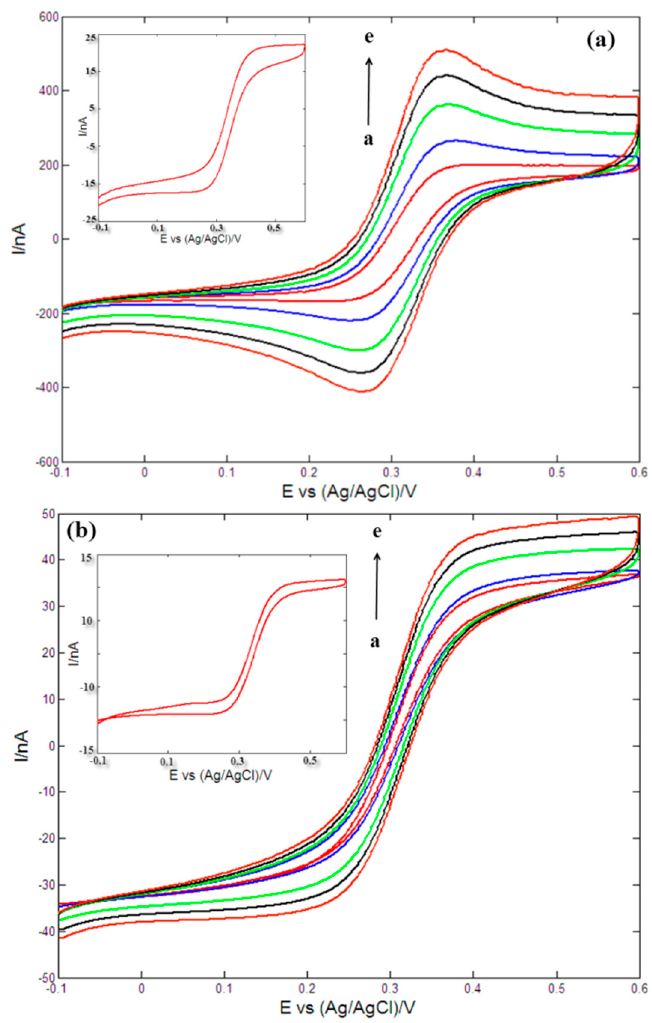
Figure 12. Cyclic voltammograms of the stimulating site modified with AuNPs ( a ) and recording site modified with AuNPs ( b ) in 0.1 M KCl solution containing 2 mM [Fe(CN) 6 ] 3 − /4 − . Scan rate: 20, 50, 100, 150 and 200 mV/s (from a to e). Inset of Figure 12a: cyclic voltammogram of bare stimulating site in 2 mM [Fe(CN) 6 ] 3 − /4 − at scan rate of 100 mV/s. Inset of Figure 12b: cyclic voltammogram of bare recording site in 2 mM [Fe(CN) 6 ] 3 − /4 − at scan rate of 100 mV/s.